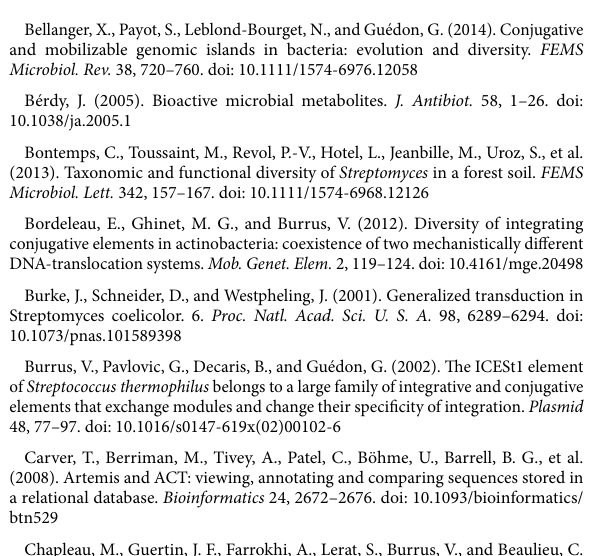
SUPPLEMENTARY TABLE S7 BlastP annotations of AICE/DAICE cargo genes. SUPPLEMENTARY TABLE S8 BlastP annotations of ICE01 cargo